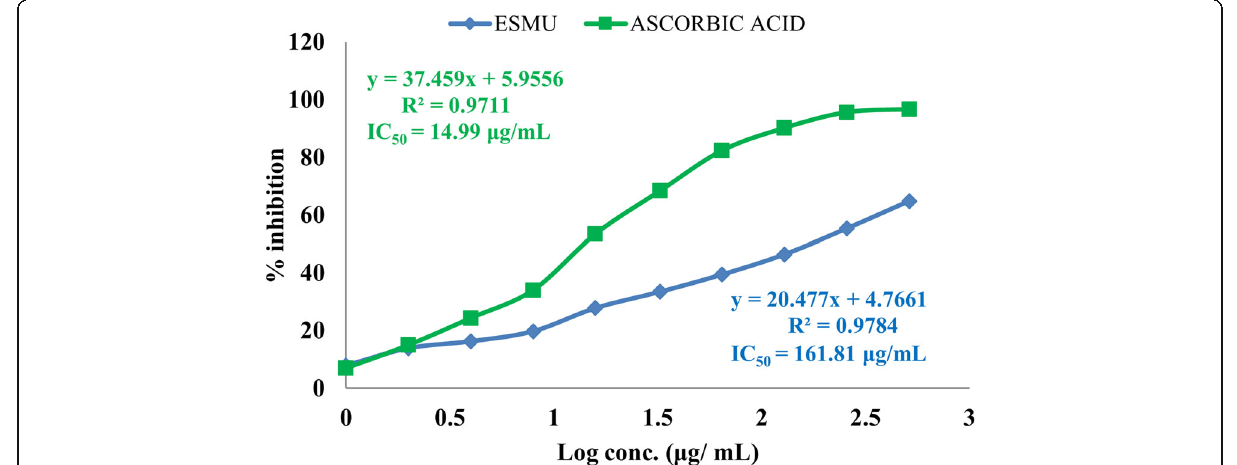
Fig. 4 DPPH scavenging activity of stem extract of Merremia